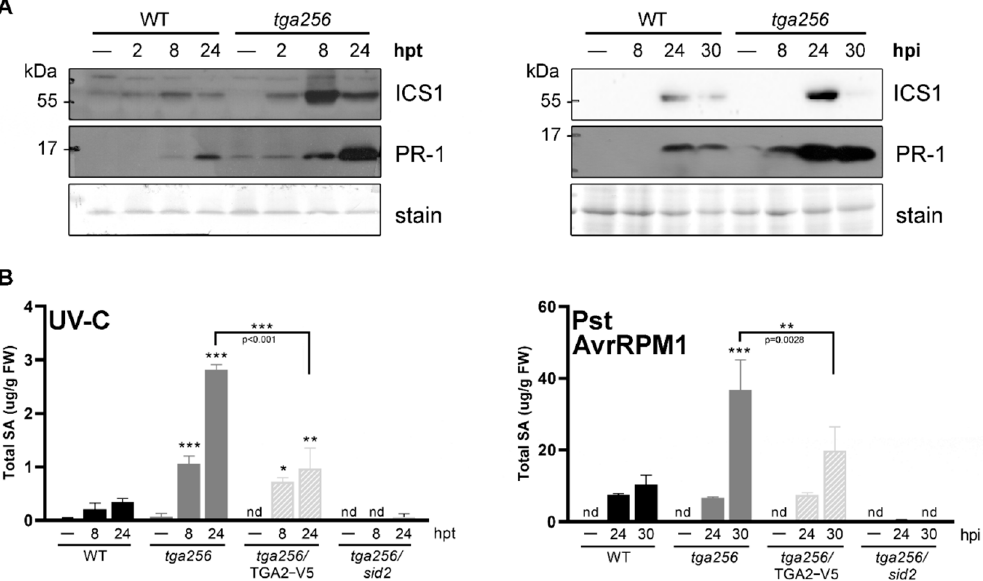
Figure 6. TGA class II negatively regulates the SA accumulation in Arabidopsis plants under stress. ( A ) Fifteen-day-old WT and tga256 mutant plants were irradiated with UV-C as described in methods (left panel). Additionally, 4-week-old WT and tga256 mutant plants were inoculated with Pst DC3000/AvrRPM1 OD λ 600 = 0.01 (right panel). Plants were frozen at indicated time points. ICS1 and PR-1 protein abundance was evaluated by Western blot. In the top right blot (ICS1), chemiluminescence was detected with CCD camera and all other blot signals were detected by X-ray film. Similar results were obtained in two additional experiments with UV-C and one additional experiment with Pst inoculation. ( B ) SA accumulation was measured in WT, tga2-1 / tga5-1 / tga6-1 ( tga256 ), tga256 /TGA2-V5 and tga2-1 / tga5-1 / tga6-1 / sid2-2 ( tga256 / sid2 ) plants. Unirradiated and non-inoculated plants were used as control ( − ). Bars represent the mean of SA detected by HPLC relative to the fresh weight of the sample ± SEM (mg SA/g FW, three biological replicates). Asterisks indicate statistically significant differences between the mutant genotypes and the WT plants at a given time point according to a 2-way ANOVA analysis and Sidak’s post-test (*: p < 0.05, **: p < 0.01, ***: p < 0.001). nd indicates that SA was not detected in the